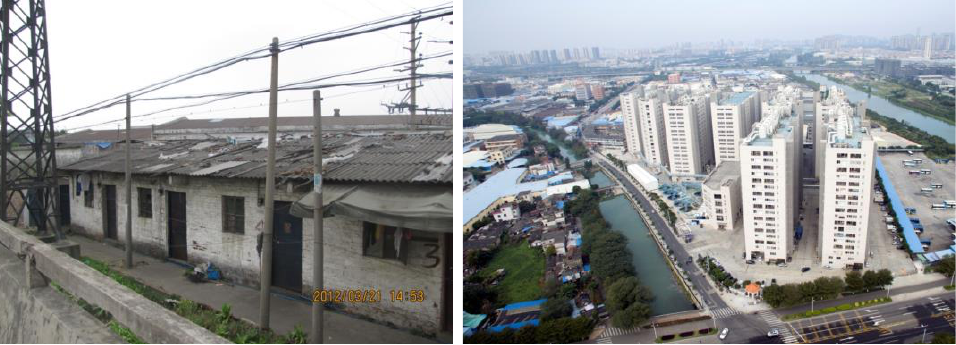
Figure 7. Before and after comparison of the renewal of Hengding Industrial Park (photo source: Urban Renewal Bureau of Shunde District).